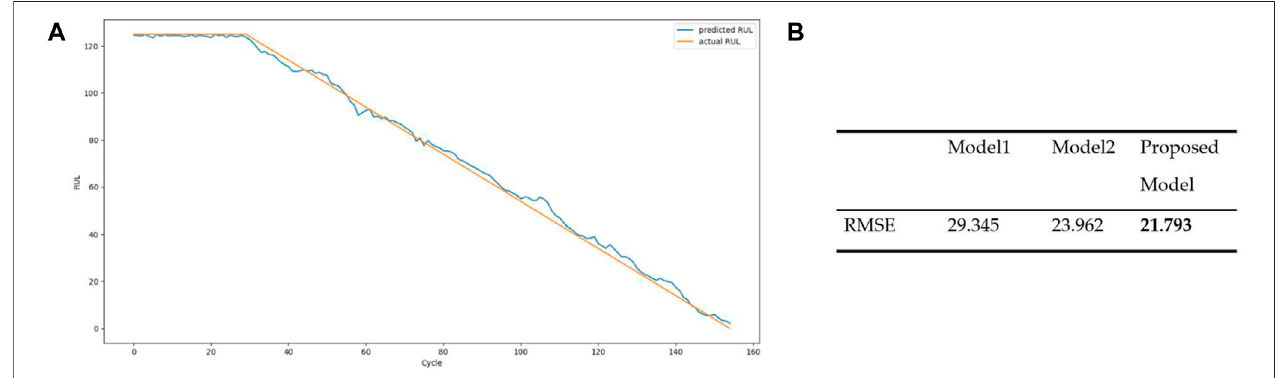
FIGURE 9 | (A) The overall model predictions over the sample dataset depicting predicted and actual RULs. (B) Model performance (RMSE) comparison.